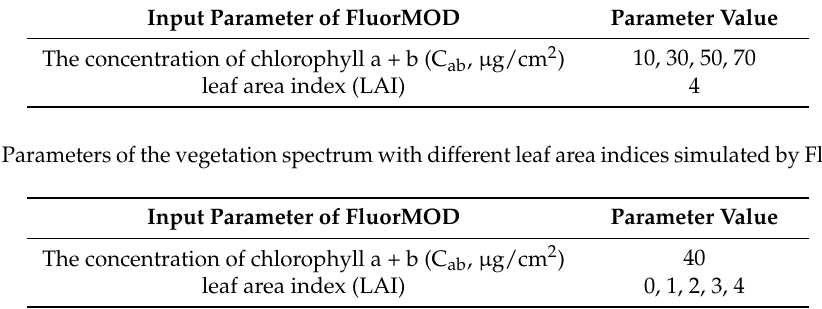
Figure 3. The vegetation reflectance spectrum with different chlorophyll contents and leaf area indices. ( a ) The vegetation reflectance spectrum with different chlorophyll contents; ( b ) the vegetation